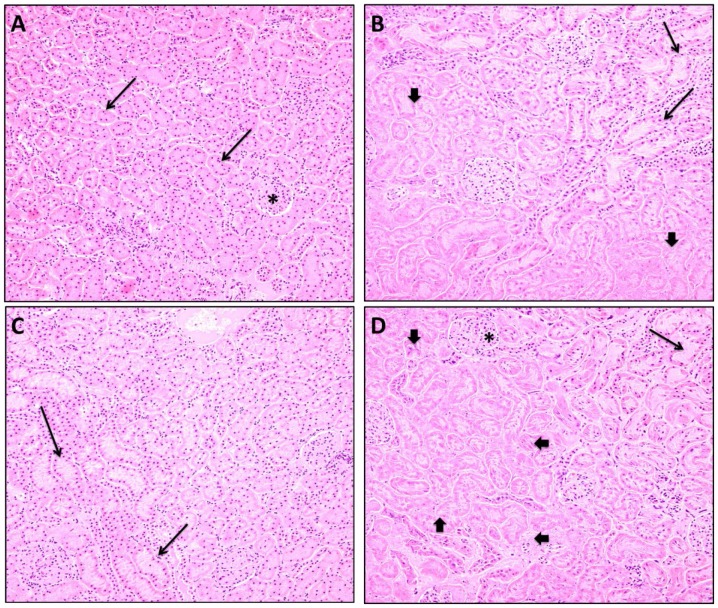
Kidney sections (40X) from vehicle+vehicle group showing glomeruli (*) and normal tubules (arrow) without dilation or necrosis.(A), vehicle+celecoxib group showing areas of moderate tubule necrosis (arrowhead) and mild tubule dilatation (arrow) (B), misoprostol+misoprostol group showing mild tubular dilatation (arrow) without necrosis (more normal tubules are seen to the right of the photomicrograph) (C), misoprostol+celecoxib group showing a large area of marked tubule necrosis (arrowhead) with relative sparing of the glomeruli (*), and moderate tubular dilation (arrow) (D).